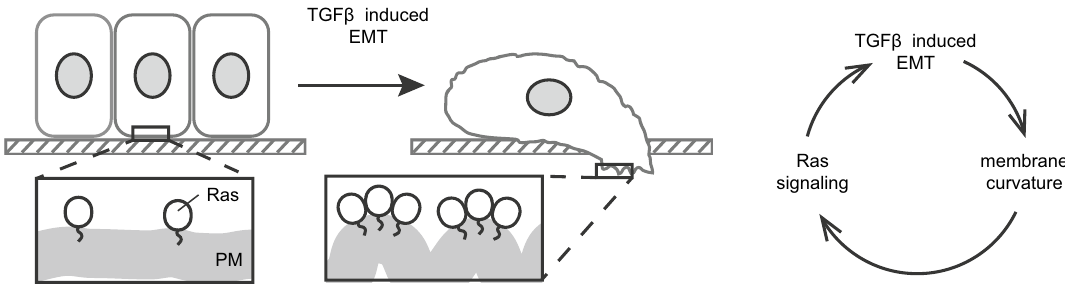
Figure 6. Model of the MC dependent regulation of Ras during TGFβ-1 induced